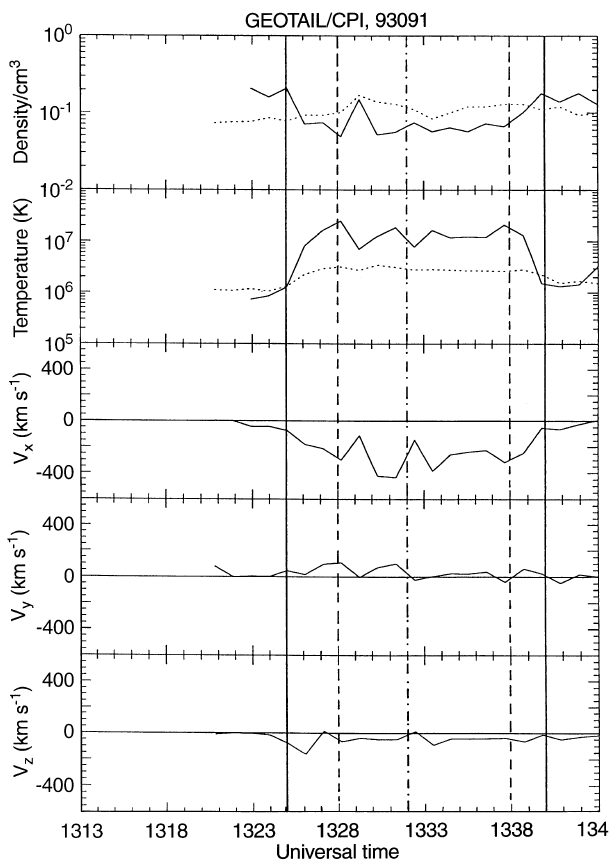
Fig. 10. The KP parameters of number densities and temperatures for protons ( solid line ) and electrons ( dashed line ) are shown in the upper two panels for the flux rope signature centred at 1331 UT on April 1, 1993. The components of proton bulk flow are shown in the lower three panels . The vertical lines are plotted as in